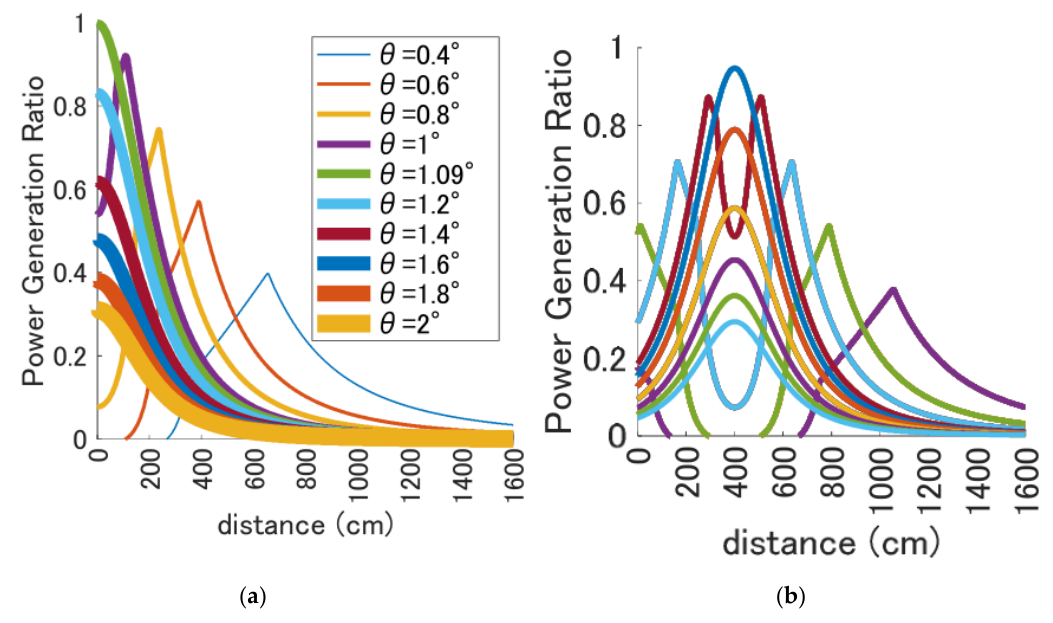
Figure 27. Power generation ratio obtained: ( a ) irradiated directly by light source; ( b ) irradiated by mirror [106].